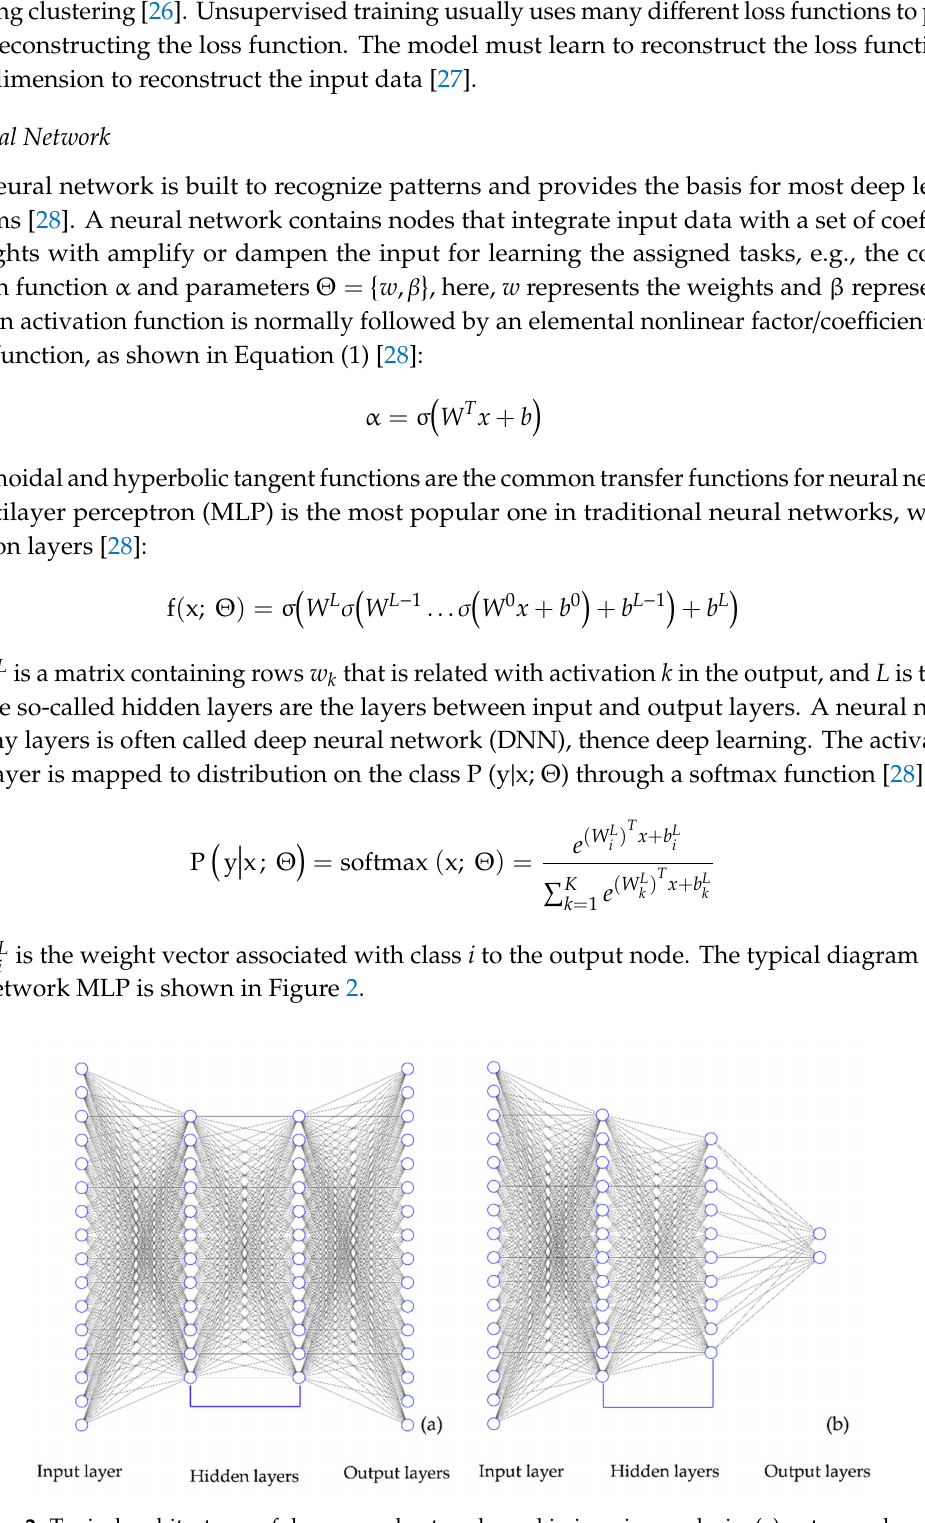
Figure 2. Typical architectures of deep neural network used in imaging analysis. ( a ) autoencoder and ( b ) convolutional neural